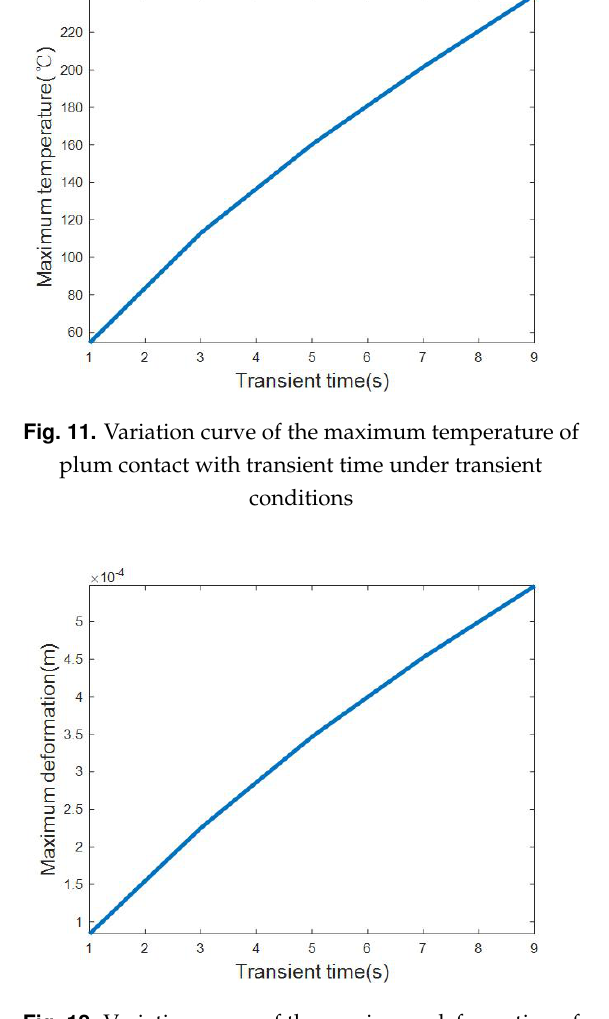
Fig. 12. Variation curve of the maximum deformation of plum contact with transient time under transient